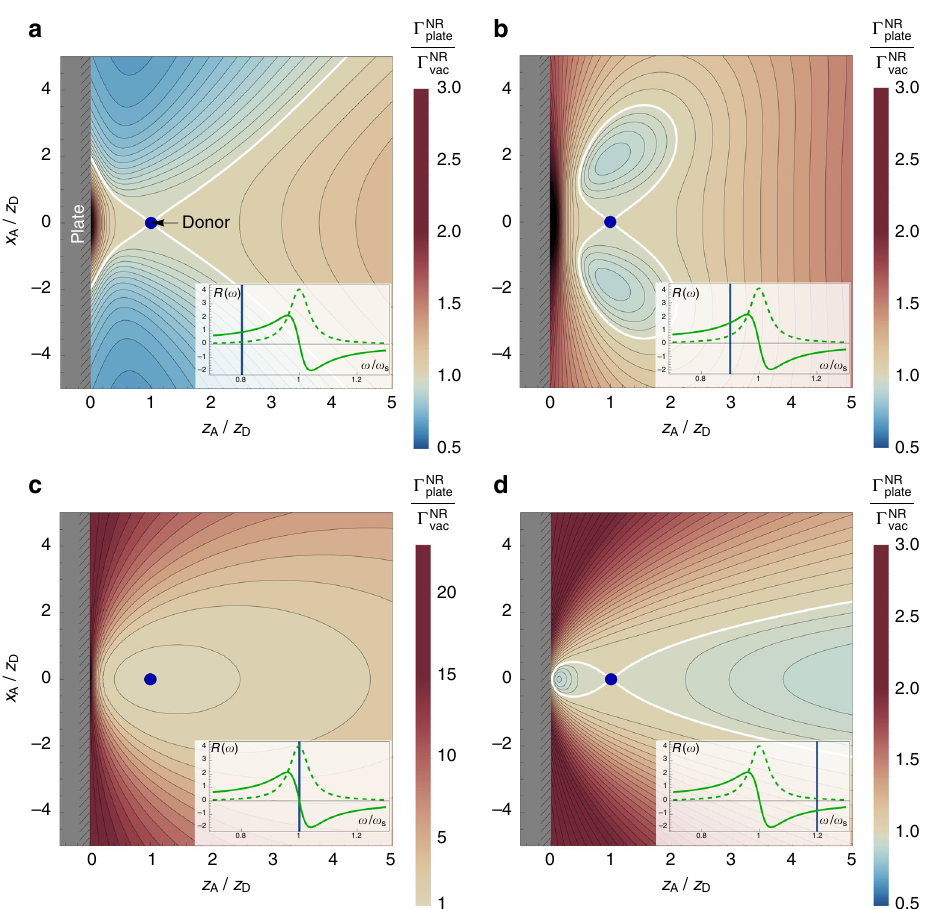
in vacuum near a dielectric surface plate . The donor is at a fi xed position on the z -axis a vac